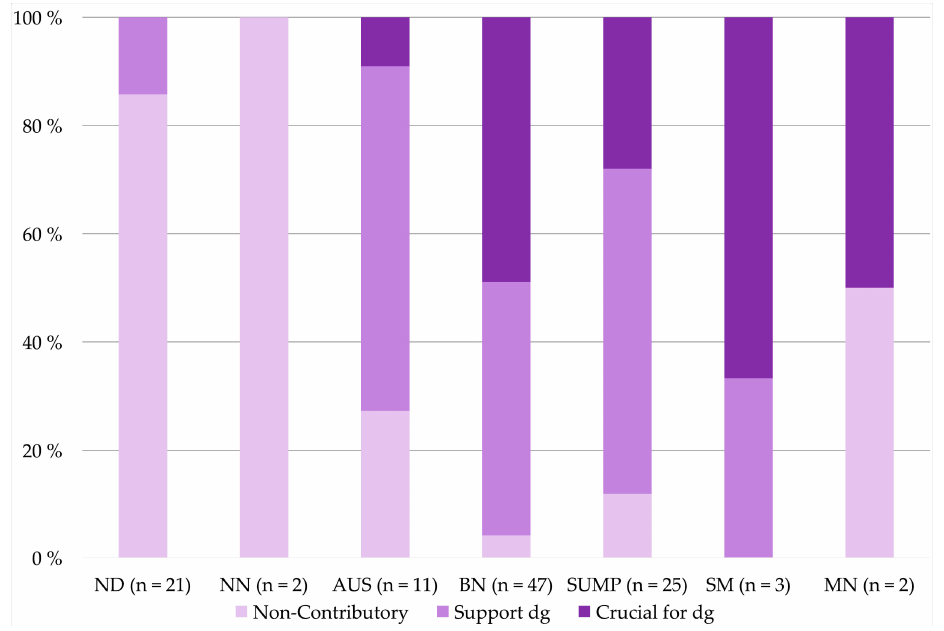
Figure 3. Milan System for Reporting Salivary Gland Cytopathology: cell block contributions of non-contributory, supporting diagnosis and crucial for diagnosis in each Milan category.